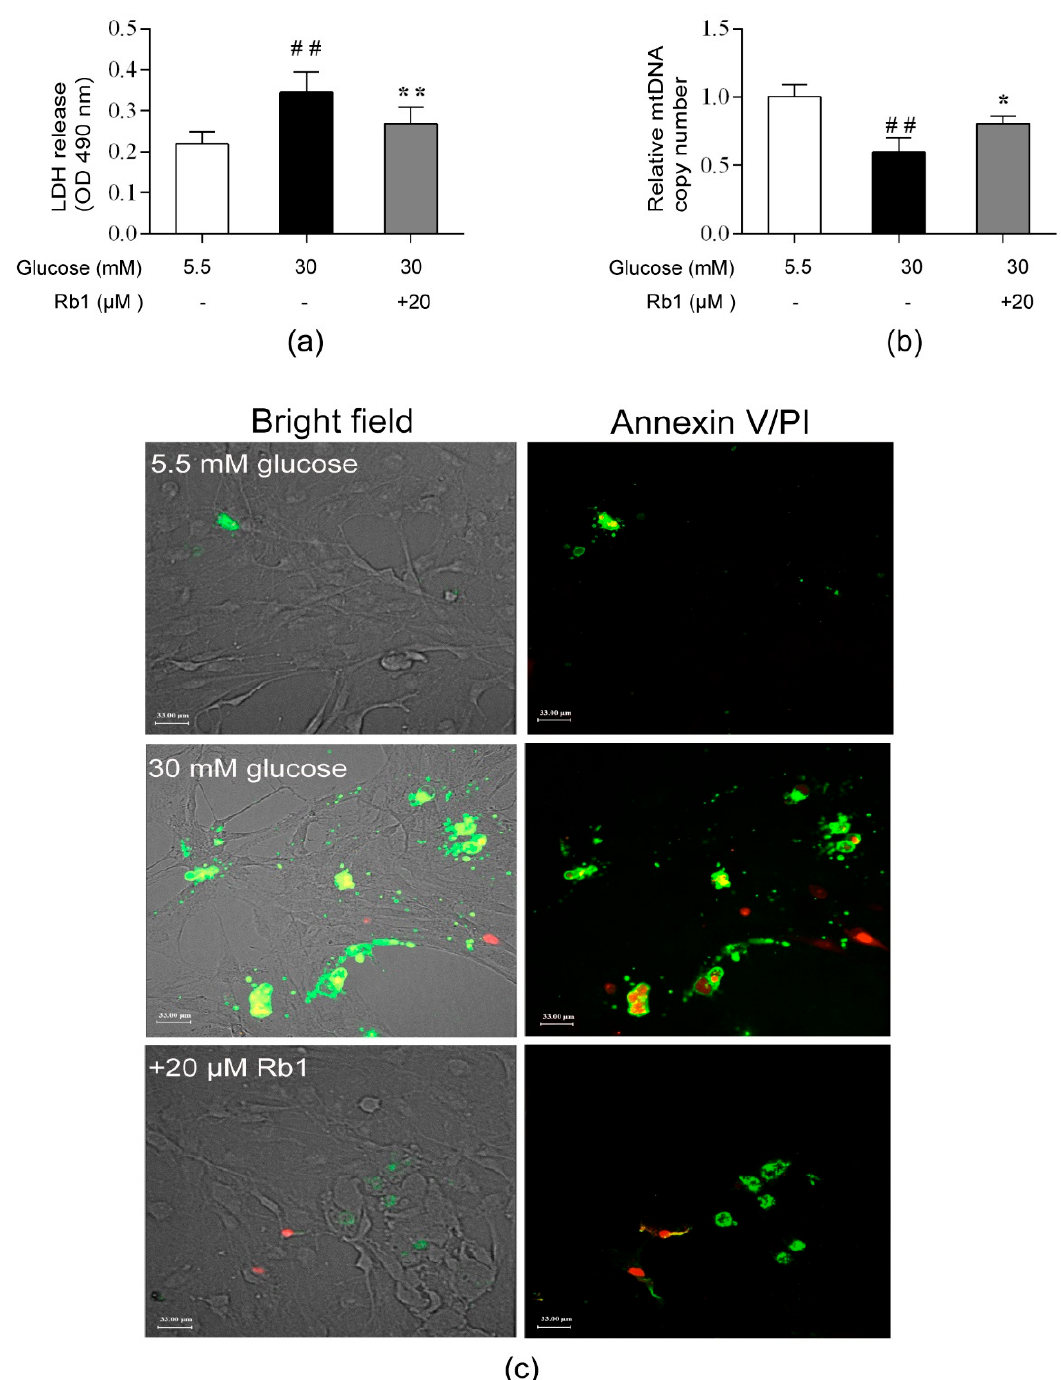
Figure 3. Rb1 ameliorated high glucose-induced cytotoxicity, DNA damage, and apoptosis in rat RCECs. ( a ) A lactate dehydrogenase (LDH) assay was used to assess the cell cytotoxicity. ( b ) The relative mtDNA copy number was estimated with real-time quantitative PCR. ( c ) Apoptosis was measured with an Annexin V-FITC/PI double staining assay and laser confocal scanning microscopy. The data are expressed as the means ± SD. ## p < 0.01 versus 5.5 mM glucose; * p < 0.05 and ** p < 0.01 versus 30 mM glucose. Scale bar: 33 μ m.